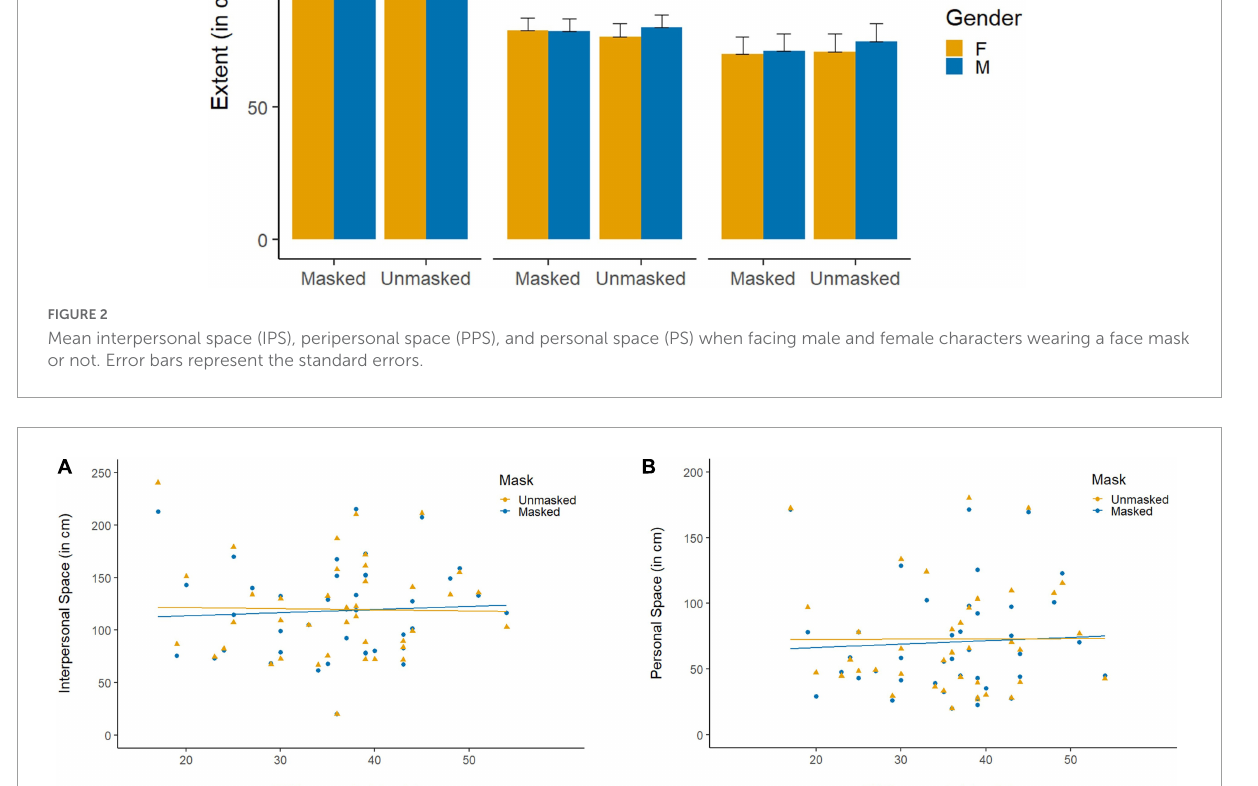
Mask × Perceived Infectability interaction, χ 2 (1) =